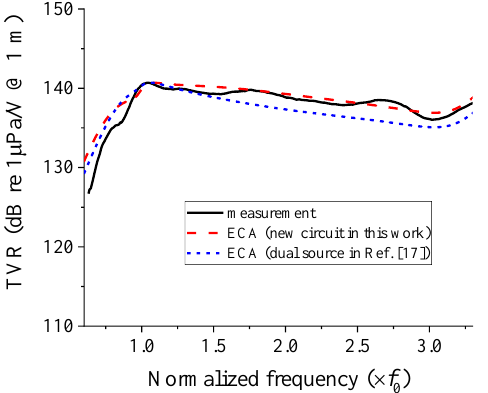
Figure 12. TVR spectra of the cymbal array from the measurement and ECA [17]. Table 1. Measured and analyzed acoustic characteristics of the cymbal array. Method